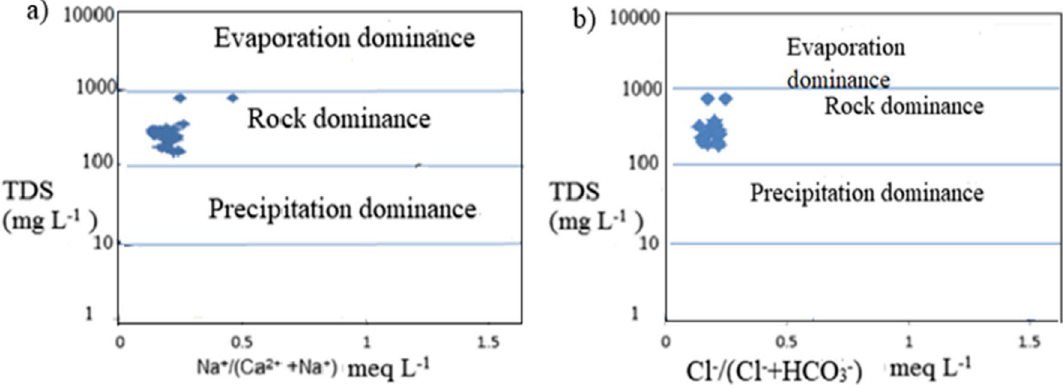
Fig. 7 Gibbs plot for mechanism controlling groundwater chemistry; a Gibbs cations ratio and b Gibbs anions